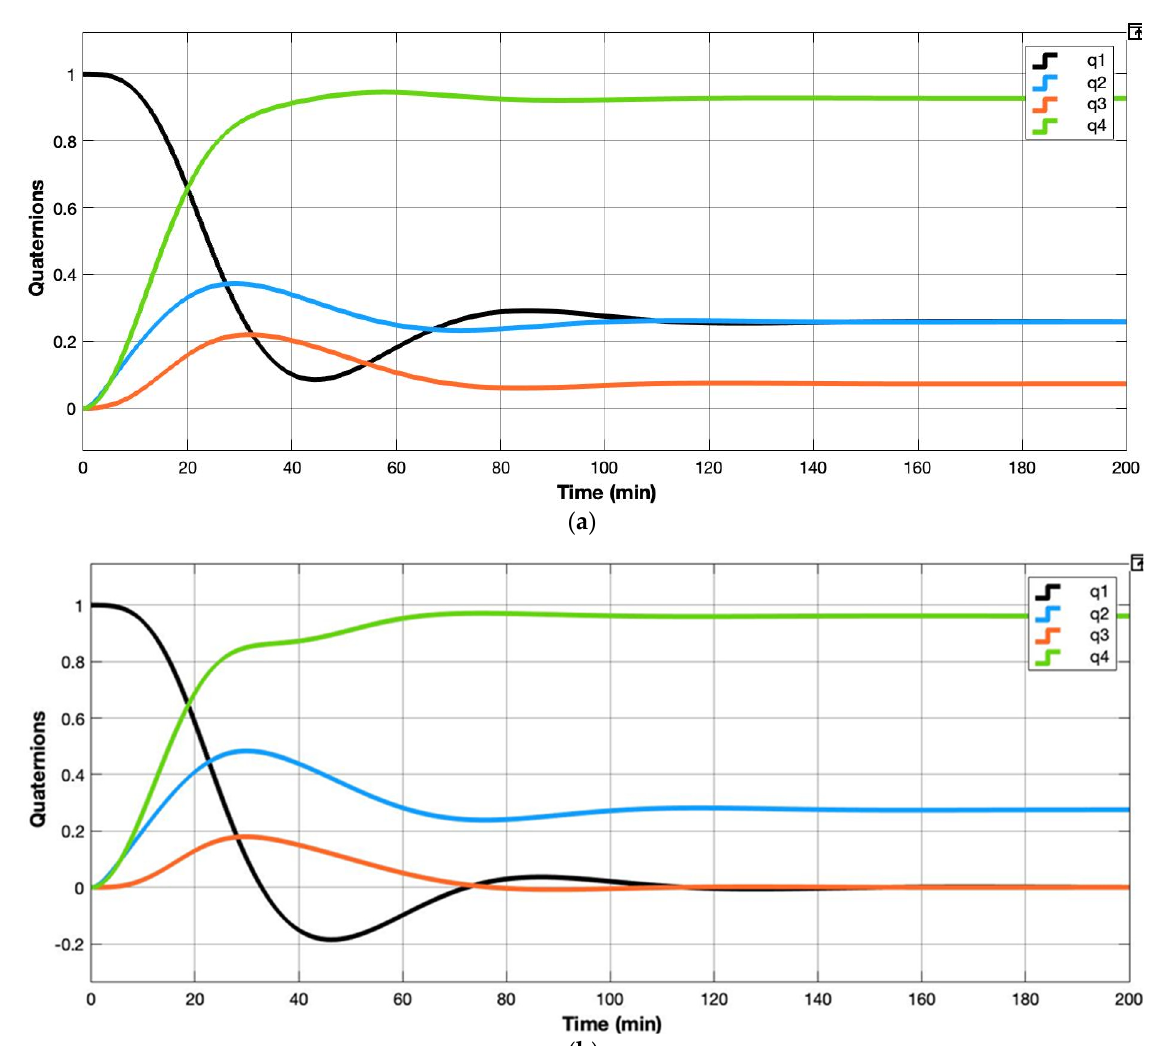
Figure 10. Quaternion response for ( a ) Vilnius and ( b ) Aalborg.